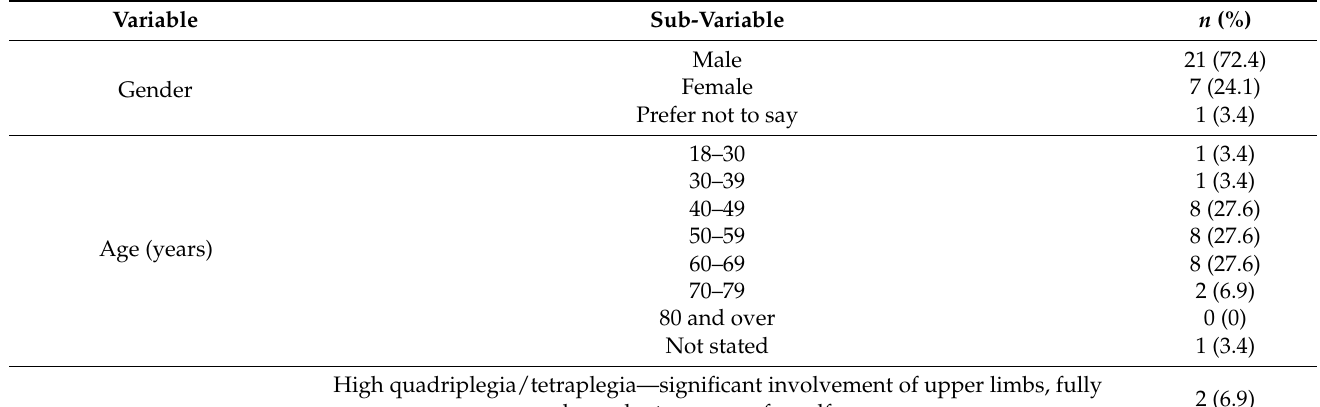
Table 1. Socio-demographic profile of respondents ( n =